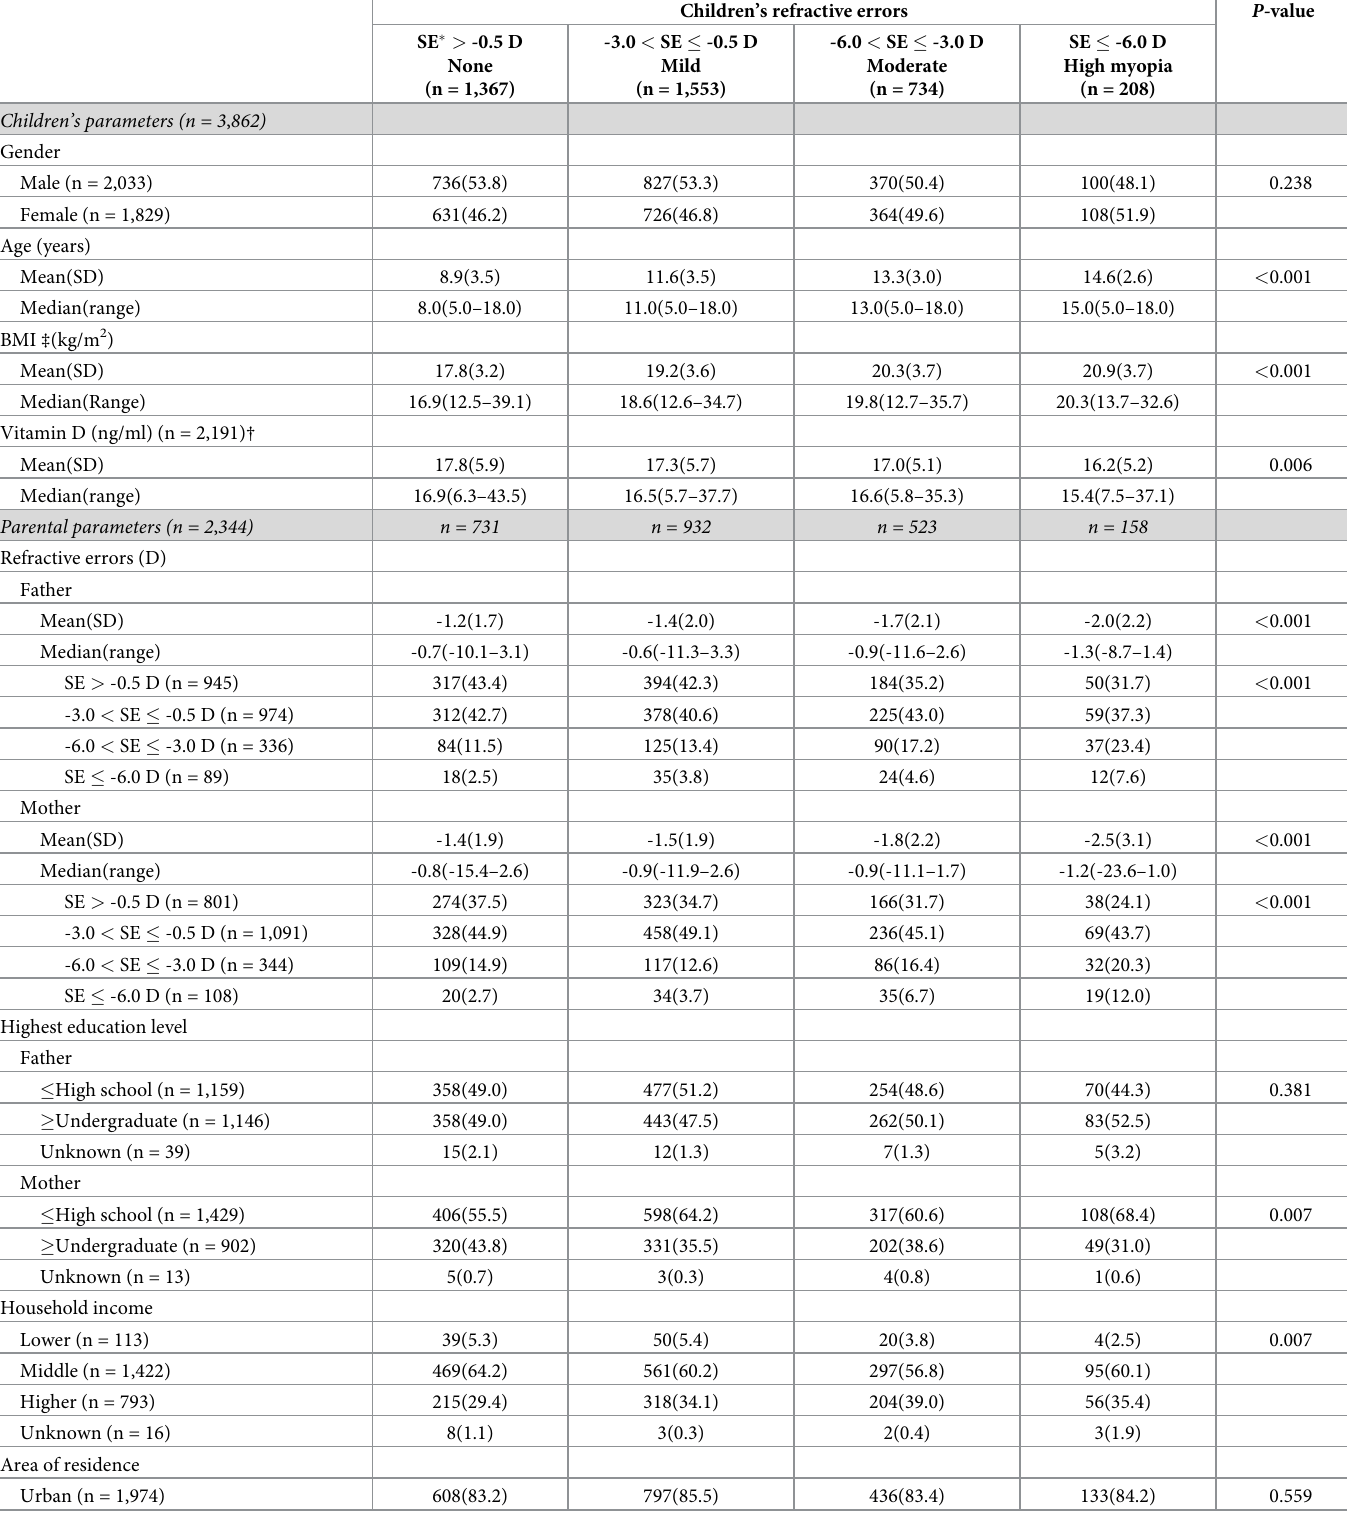
Table 1. Characteristics of the study participants according to children’s refractive